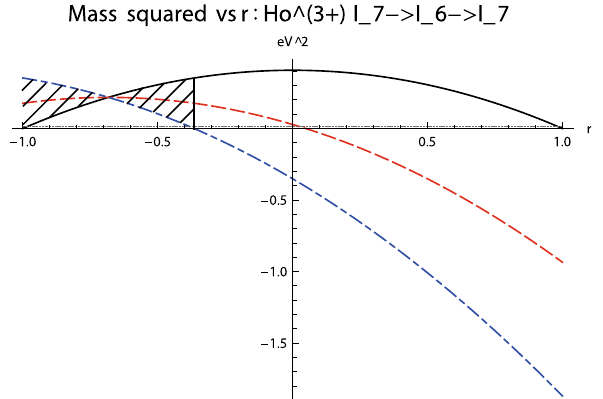
Fig. 4 Mass squared M 2 (θ ; r ) vs r for three angles: θ = 0 in solid black, θ = π/ 2 in dashed red, and θ = π in dash-dotted blue. The line M 2 (θ ; r ) = 4 ( 60meV ) 2 (expected (33) mass square M 2 assuming the smallest neutrino mass (cid:15) 10 meV ) is shown in dotted black as a guide. It is concluded that no McQ3 is expected for r ≤ − 0 . 36532 as shown in the shaded region where M 2 (θ ; r ) > 0 for all angles. At r = − (cid:5) pe /(cid:5) eg there is no dependence of rates on emission angle